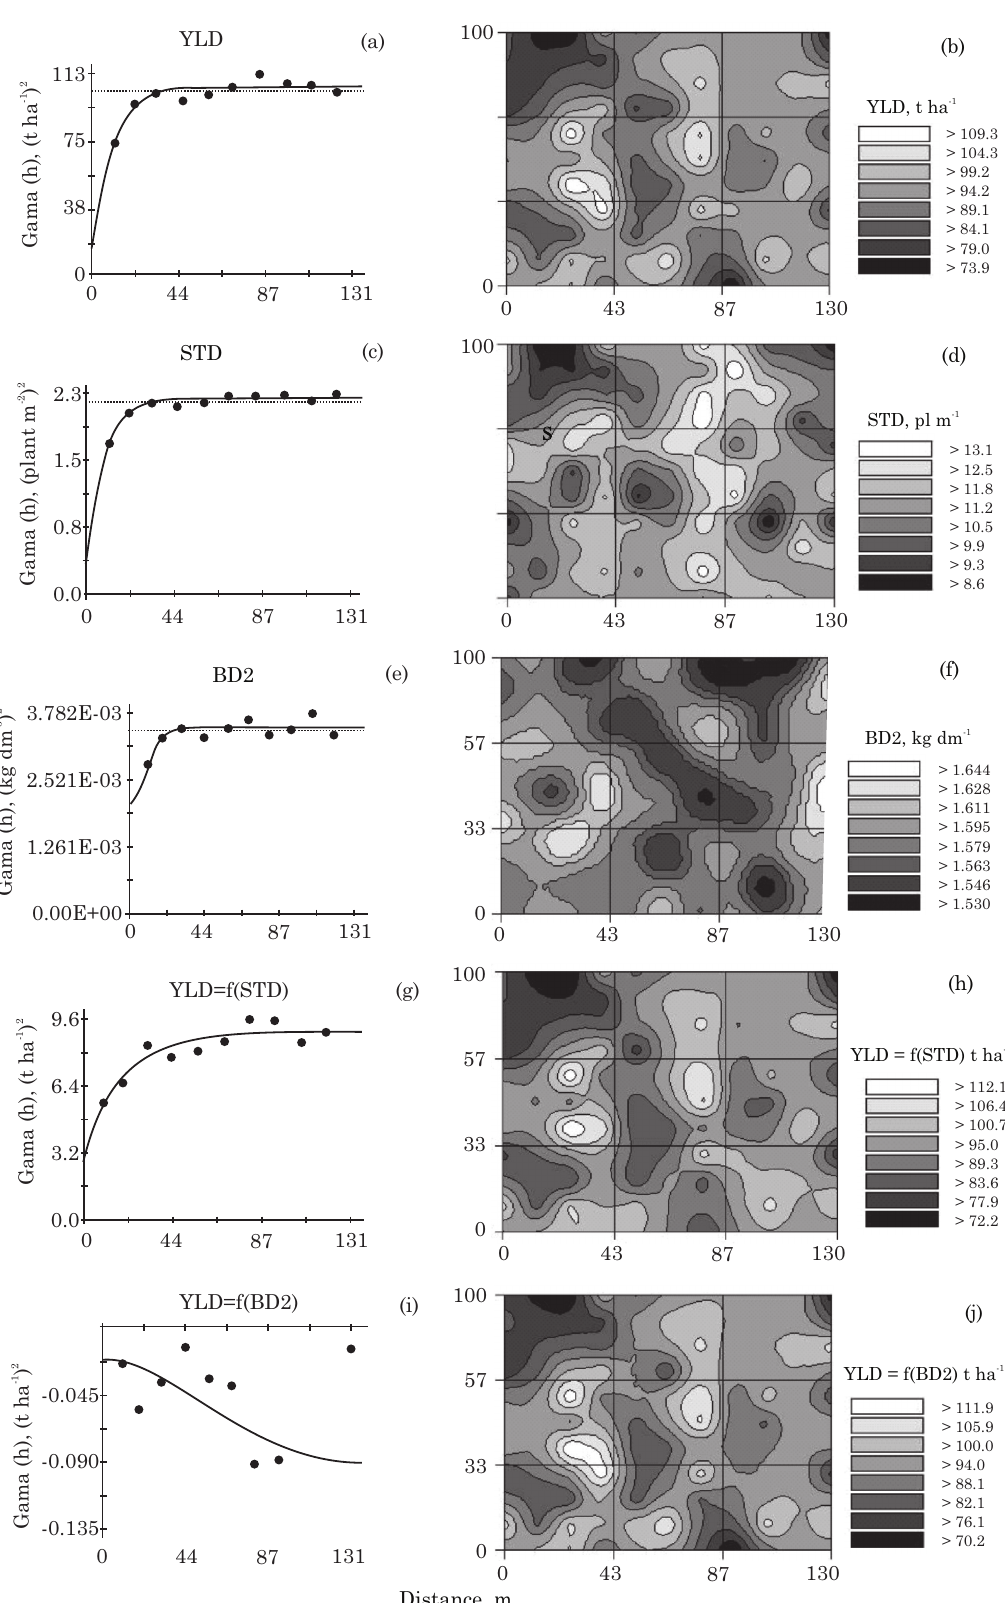
Figure 2. Single and cross semivariogram and maps cokriging properties of sugarcane and BD2 of an Ultisol, in the treatment in which the trash was left on the ground